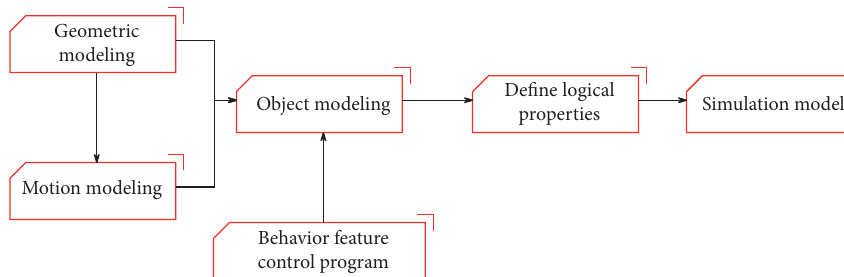
Figure 8: The process of establishing a simulation model.